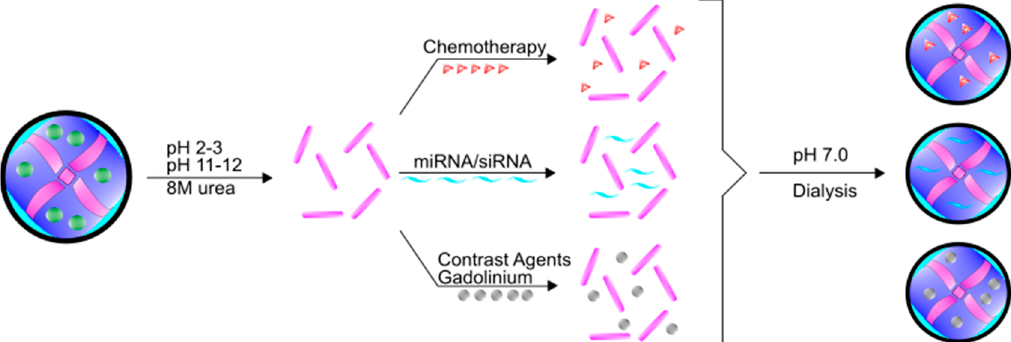
Figure 3. Schematic of encapsulation paradigms for ferritin. Fully formed 24-mer ferritin molecules can be disassembled using 8 M urea or acidic (pH 2–3) or basic (pH 11–12) conditions. A number of different molecules can be mixed with the disassembled ferritin, including chemotherapies, siRNAs/miRNAs, and contrast agents. Upon returning the ferritin mixture to neutral conditions (pH 7.0) coupled with dialysis, ferritin will spontaneously form the 24-mer around the molecule of interest. Free molecules can be dialyzed away from solution.